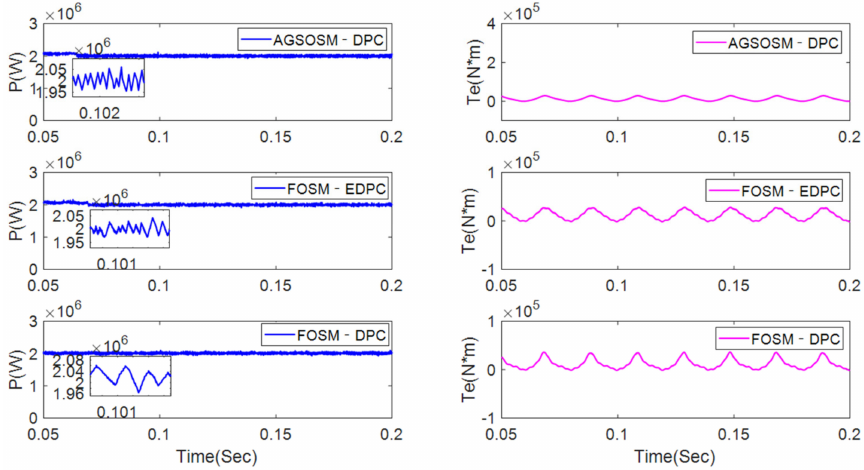
Figure 8. Active power and electromagnetic torque under unbalanced grid